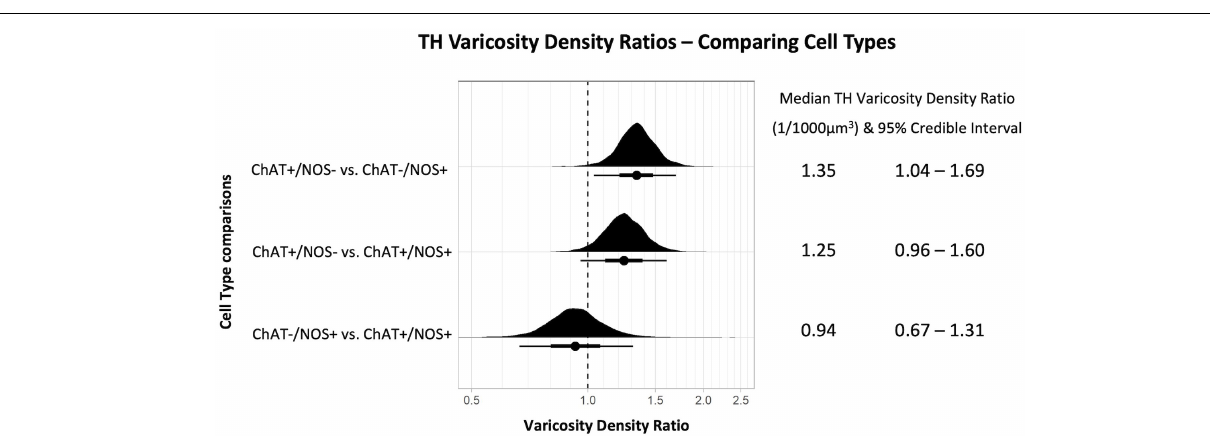
cells surrounded by ENK + baskets (see Table 2 ). Examples